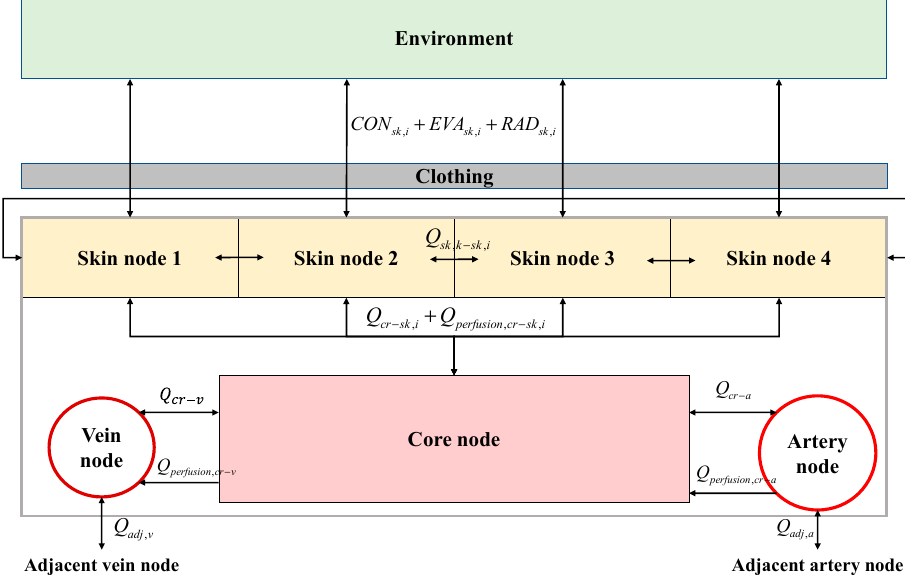
Figure 2. Schematic diagram of heat transfer between the core, artery, vein, and four skin nodes.